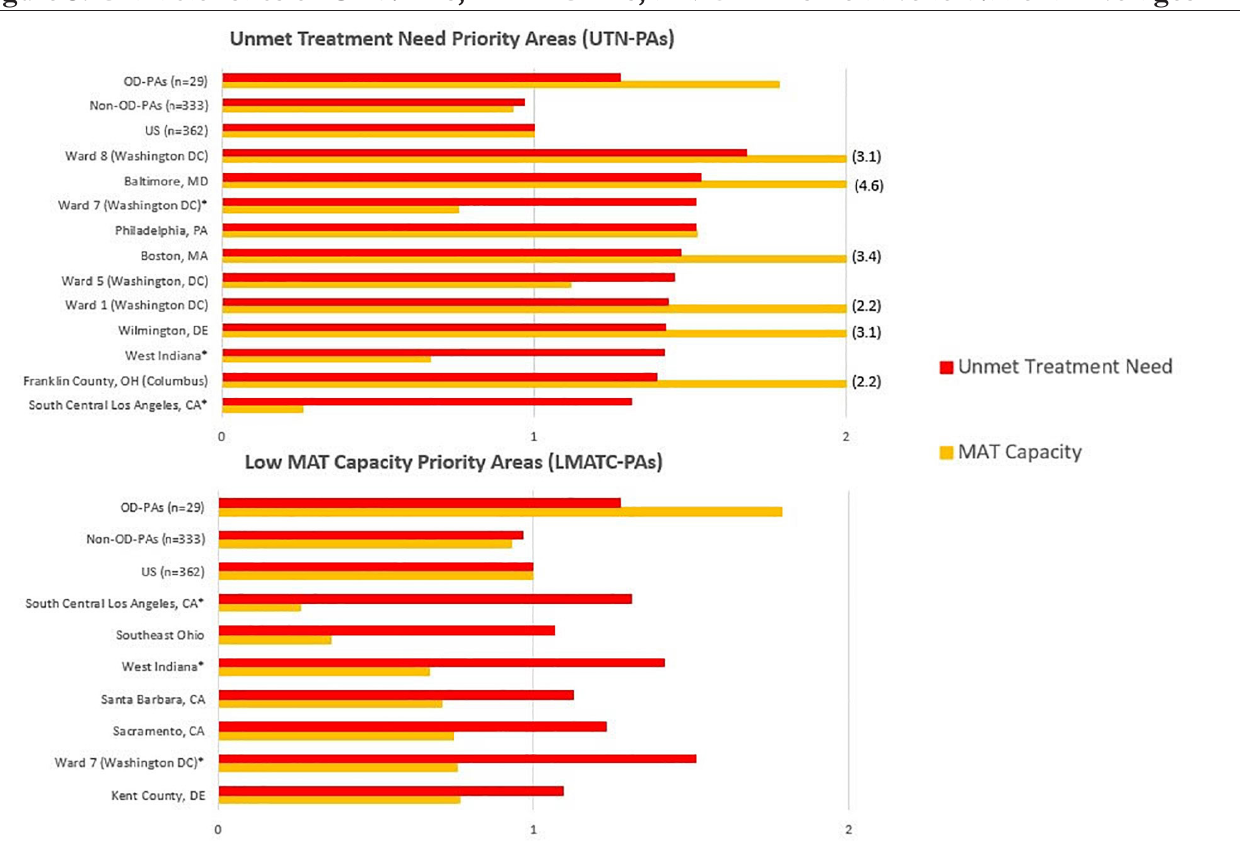
Figure 3. Characteristics of UTN-PAs, LMATC-PAs, and OD-PAs Relative to National